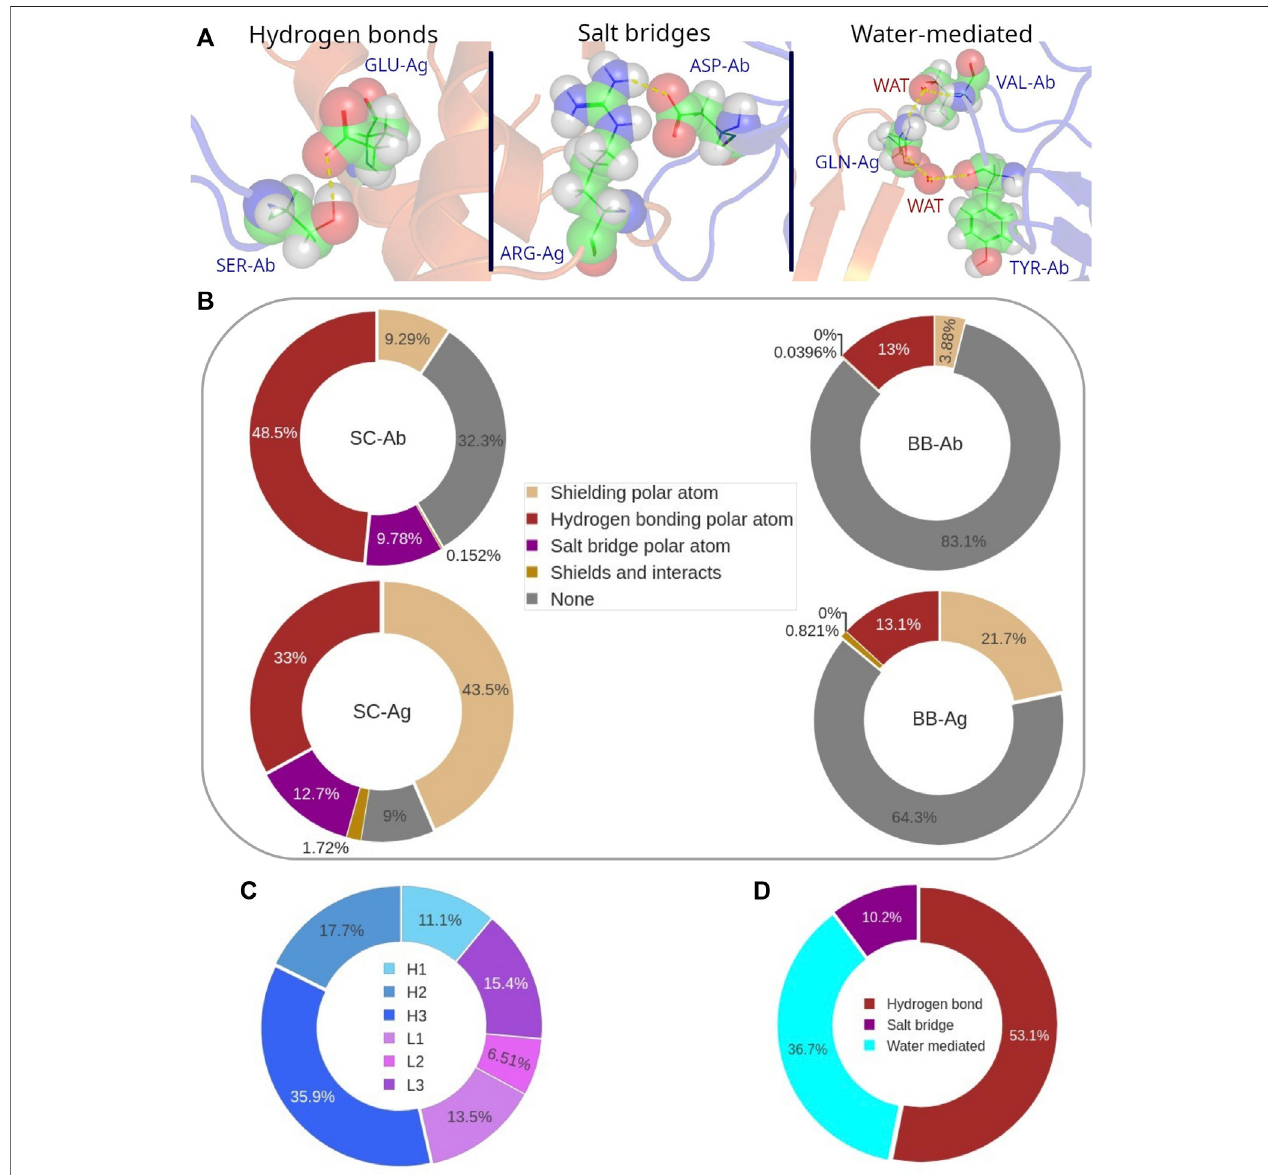
FIGURE 8 | (A) Graphical representation of the different types of polar interactions. (B) Distribution of the different roles of polar atoms at the Ab-Ag interface. Participation (in %) of the polar atoms in each CDR to the polar bonds. (C) Participation of each CDR in polar interactions. (D) Distribution probability of H-bonds, salt bridges and water-mediated interactions to all polar